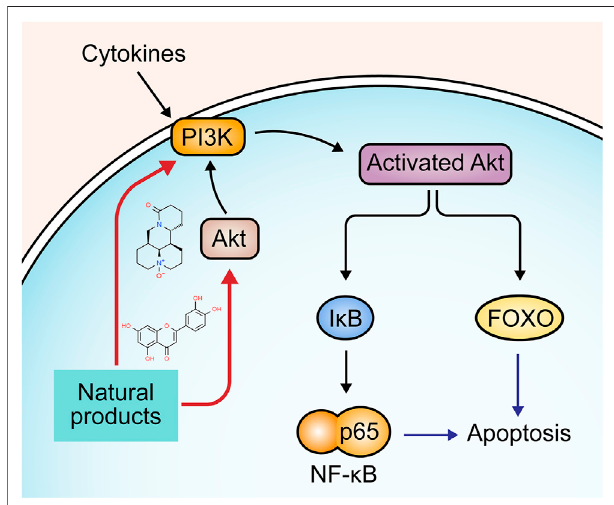
FIGURE 6 | Natural products modulate apoptosis of IECs through P13K/Akt